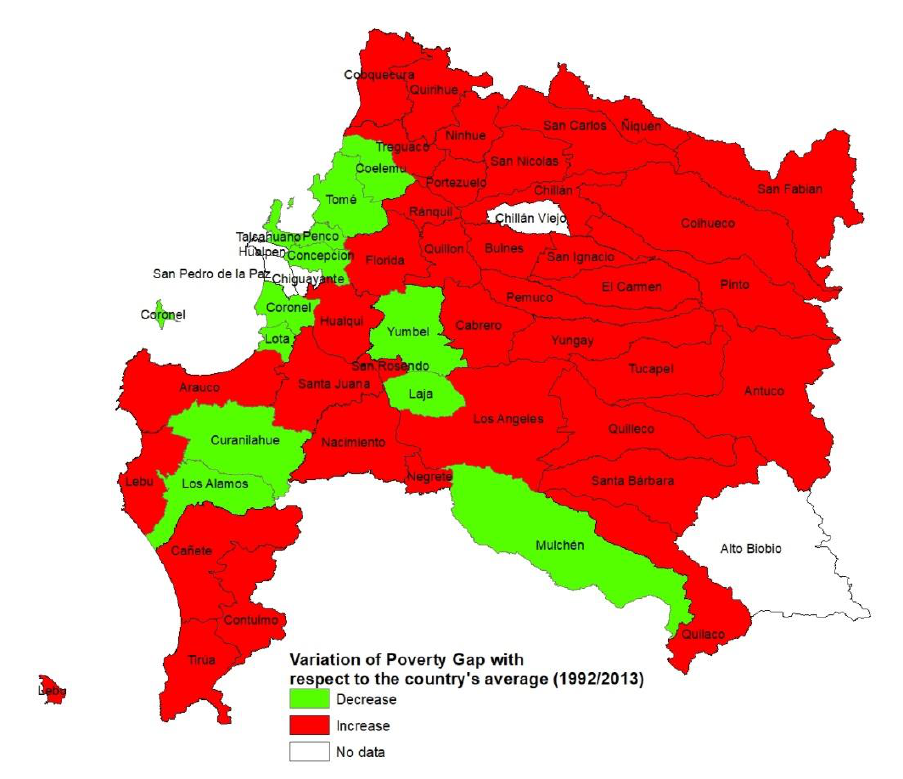
Figure 8. Variation of the poverty gap by county with respect to the country’s average value between 1992 and 2013.